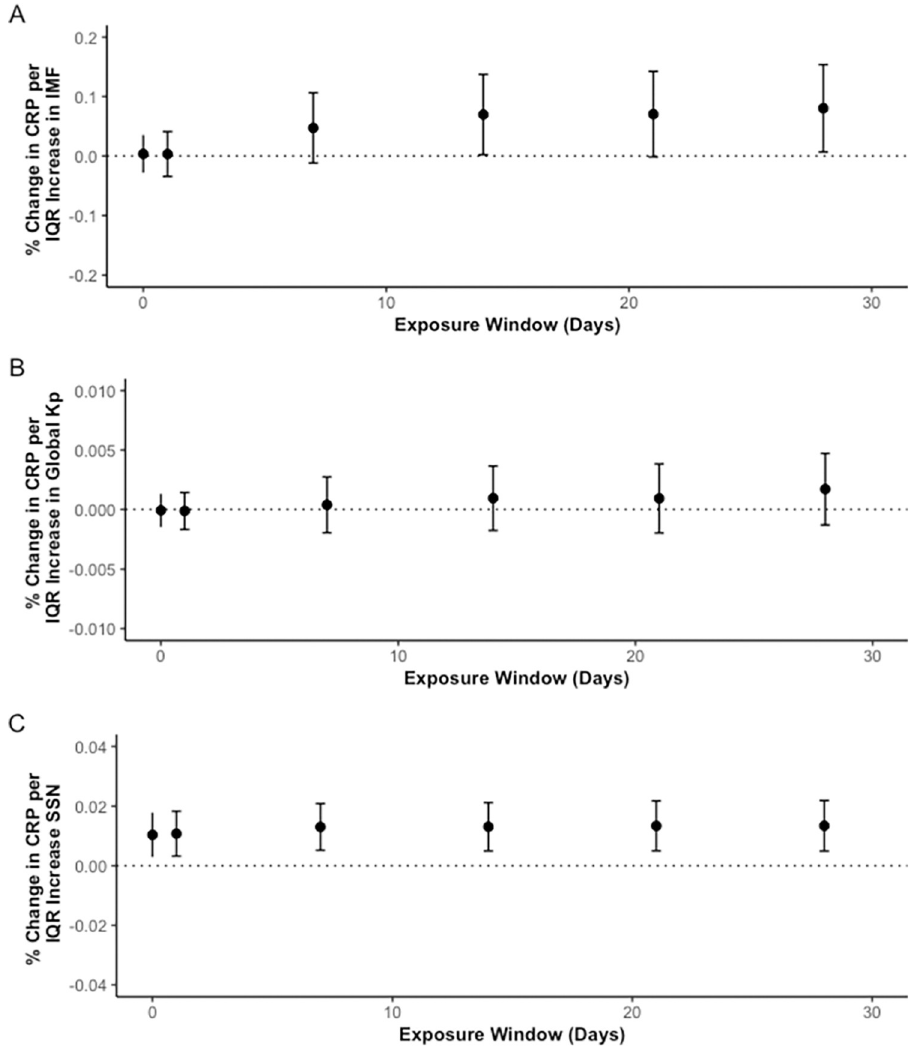
Fig 3. Percent change in CRP concentrations per IQR increase in IMF (A), K p index (B), and SSN (C) over 28 day moving averages. � y-axes have different